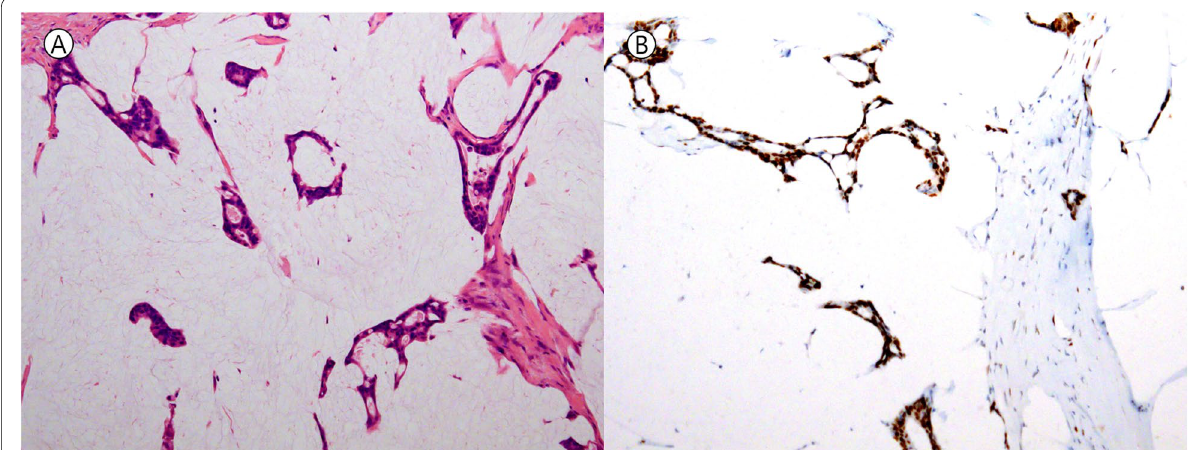
Fig. 2 Mucinous adenocarcinoma of the colon that experienced neo‑adjuvant chemoradiation therapy but did not show any TP53 mutation. A Several strips or clusters of tumor cells are floating in the mucin pool (Hematoxylin & Eosin, noted (p53 immunohistochemistry, 10 objective ×